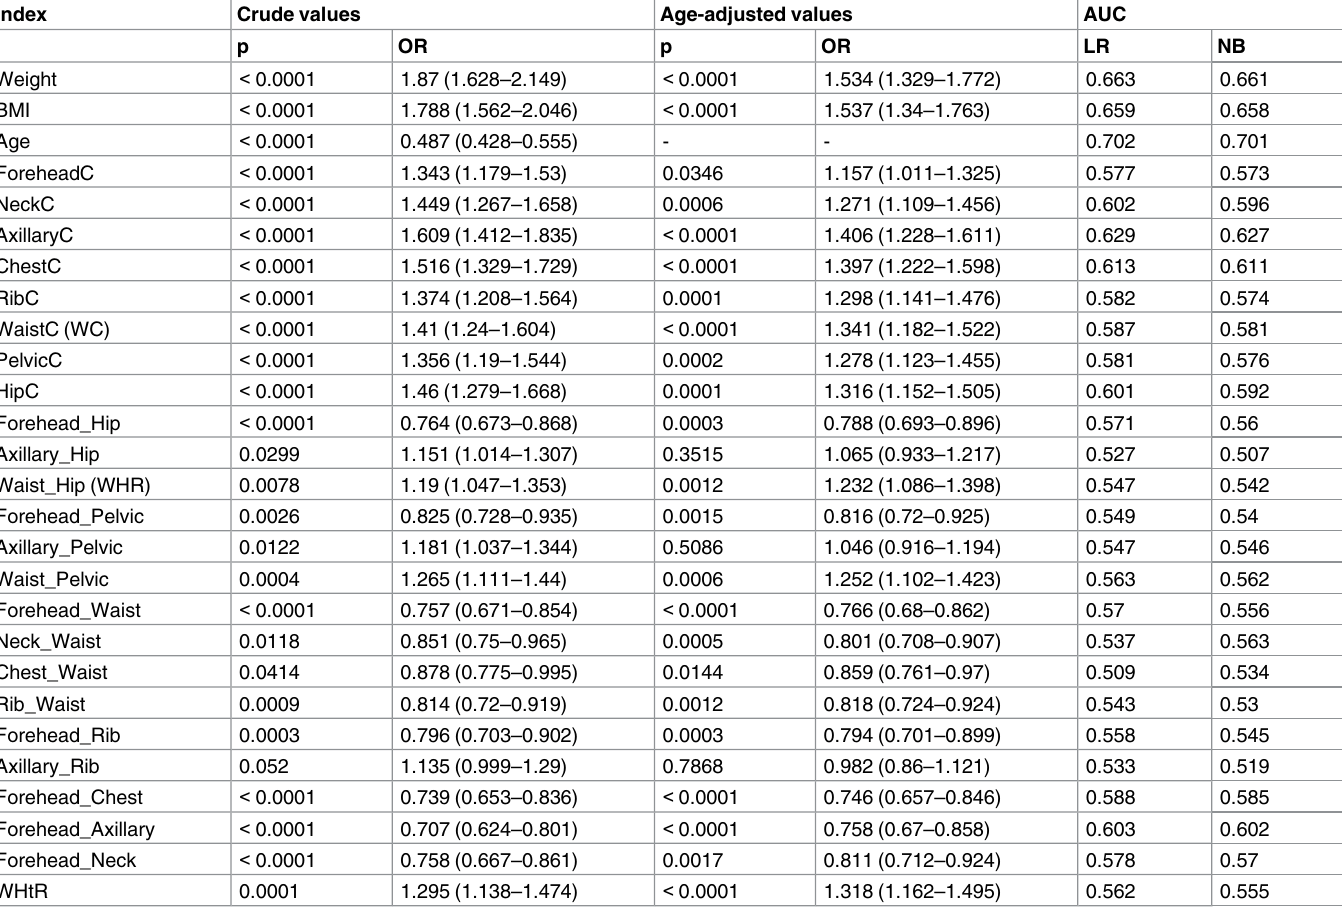
Table 2. The associations between anthropometric indices and the hemoglobin level in